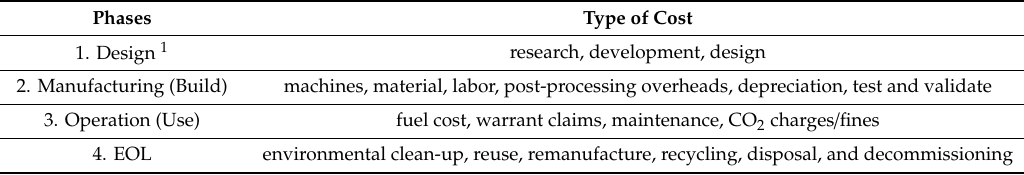
Table 2. Representation of life cycle cost (LCC) phases of L-PBF manufacturing.